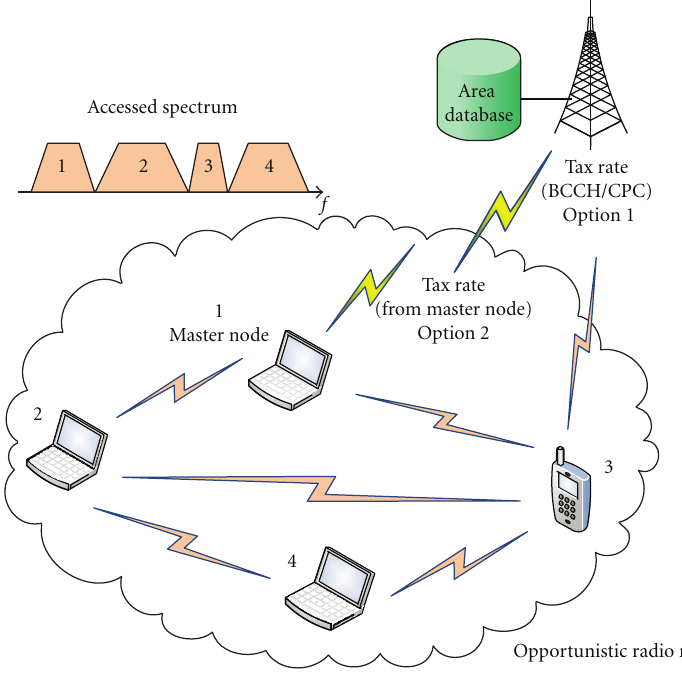
Figure 1: The scenery of the cognitive radio network with the taxation-based opportunistic spectrum access.